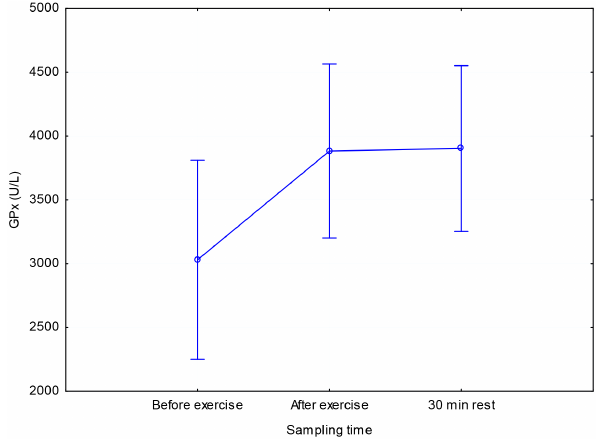
Figure 1. Changes in glutathione peroxidase (GPx) activity during the training period ( P =